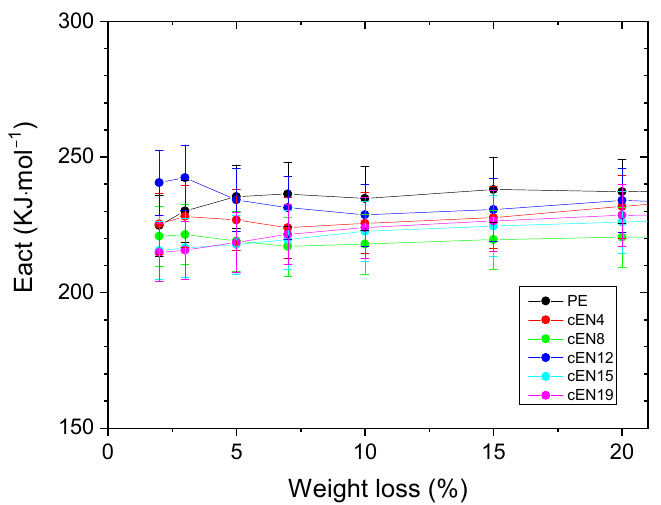
Figure 11. Activation energies associated with the weight loss under inert conditions (bars correspond to a relative error of 5%).